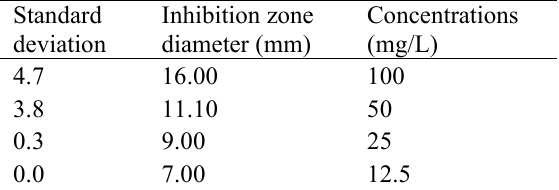
Table 3. The diameter of inhibition zone due to the effects of AuNPs-vancomycin concentrations Standard Inhibition zone deviation diameter (mm)